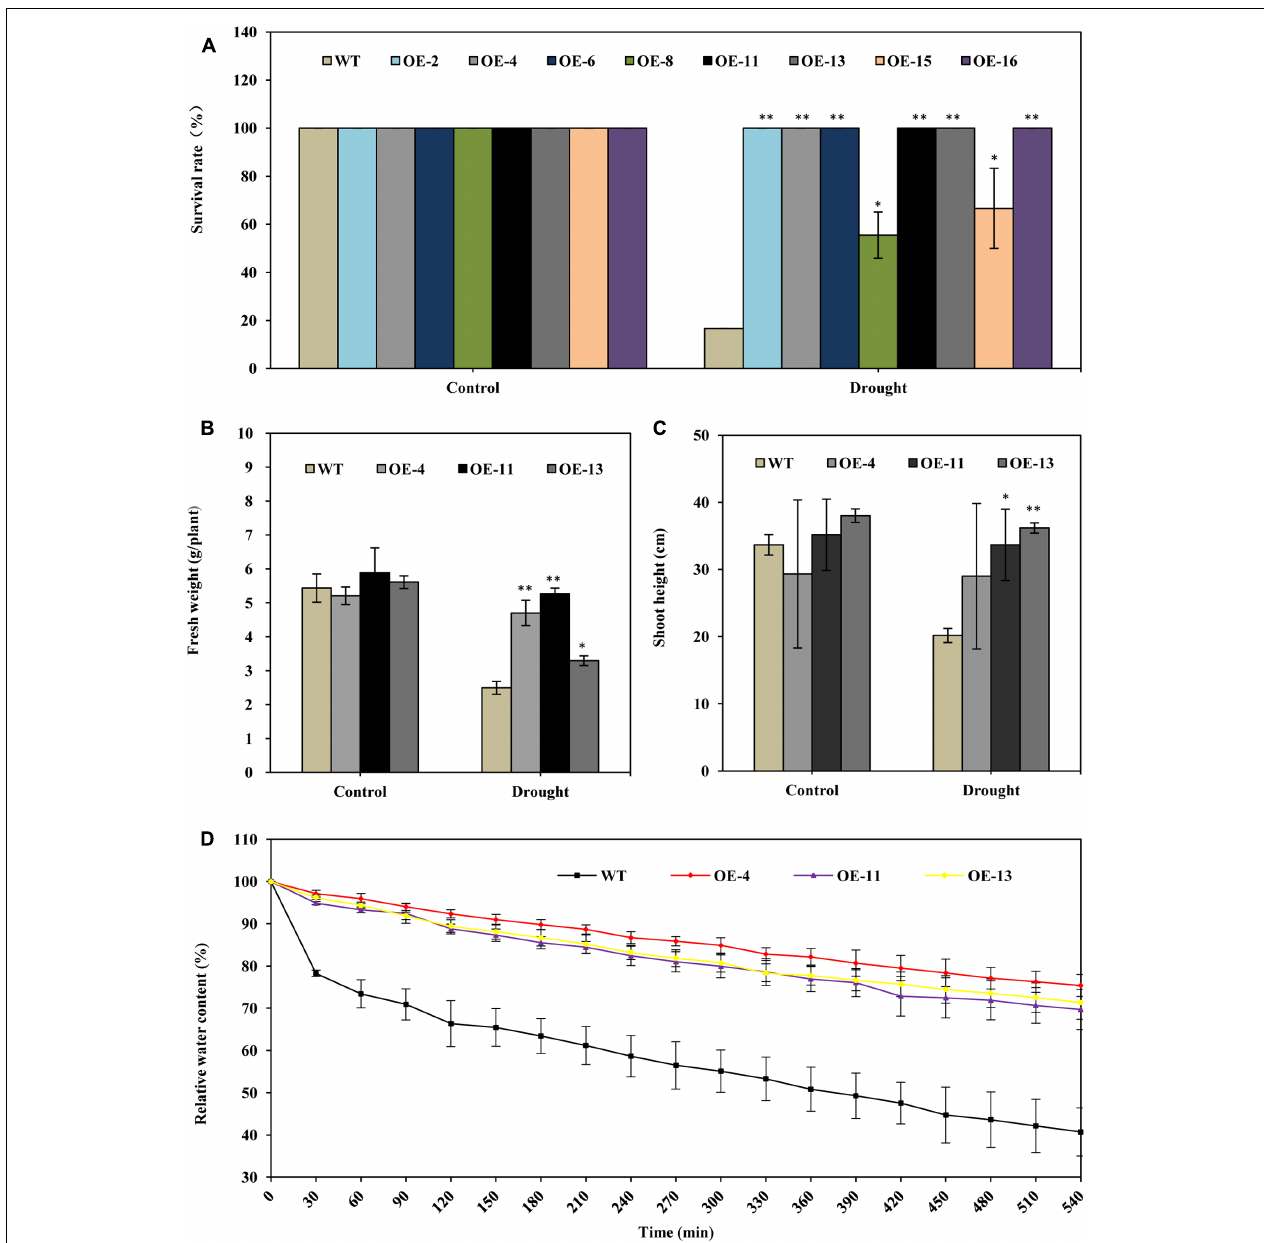
FIGURE 3 | AtEDT1 significantly enhanced the drought tolerance of transgenic alfalfa plants. (A) Survival rate of the alfalfa plants after drought treatment followed by 10-day-recovery. Values are means ± standard deviations (SD) of six replicates ( ∗ P < 0.05, ∗∗ P < 0.01). (B,C) Fresh weight and shoot height of alfalfa after 10-day-recovery. Values are means ± SD of six replicates ( ∗ P < 0.05, ∗∗ P < 0.01). (D) Water content of wild type and transgenic alfalfa plants. Detached leaves (around 0.5 g) were exposed to air, and fresh weight was measured at the indicated time points. Values are means ± SD of six